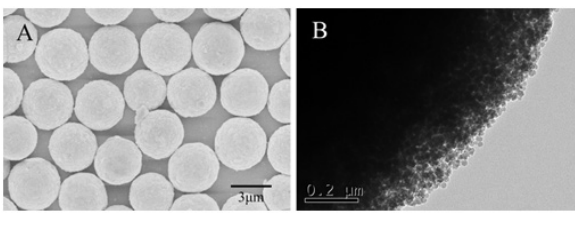
Figure 4: The SEM (A) and TEM (B) images of PSMs